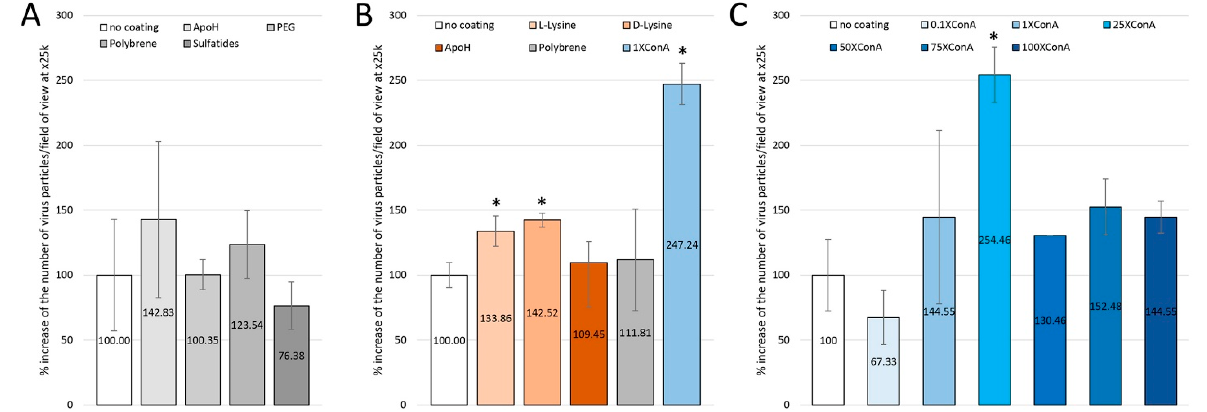
Figure 2. SEM quantification of the abundancy of SARS-CoV-2 virus-like particles after deposition of VeroE6 infected cell supernatants on Lab-Tek glass slides. ( A ): Comparison of abundancy of SARS-CoV-2-like particles between no coating and ApoH, PEG, Polybrene or Sulfatides coating conditions. ( B ): Comparison of abundancy of SARS-CoV-2-like particles between no coating and poly-L-lysine, poly-D lysine, ApoH, Polybrene and 1XConA coating conditions. ( C ): Comparison of abundancy of SARS-CoV-2-like particles between no coating and 0.1XConA, 1XConA, 25XConA, 50XConA, 75XConA and 100XConA coating conditions. Error bars represent standard deviations. *: p -value < 0.05, Student’s t -test.